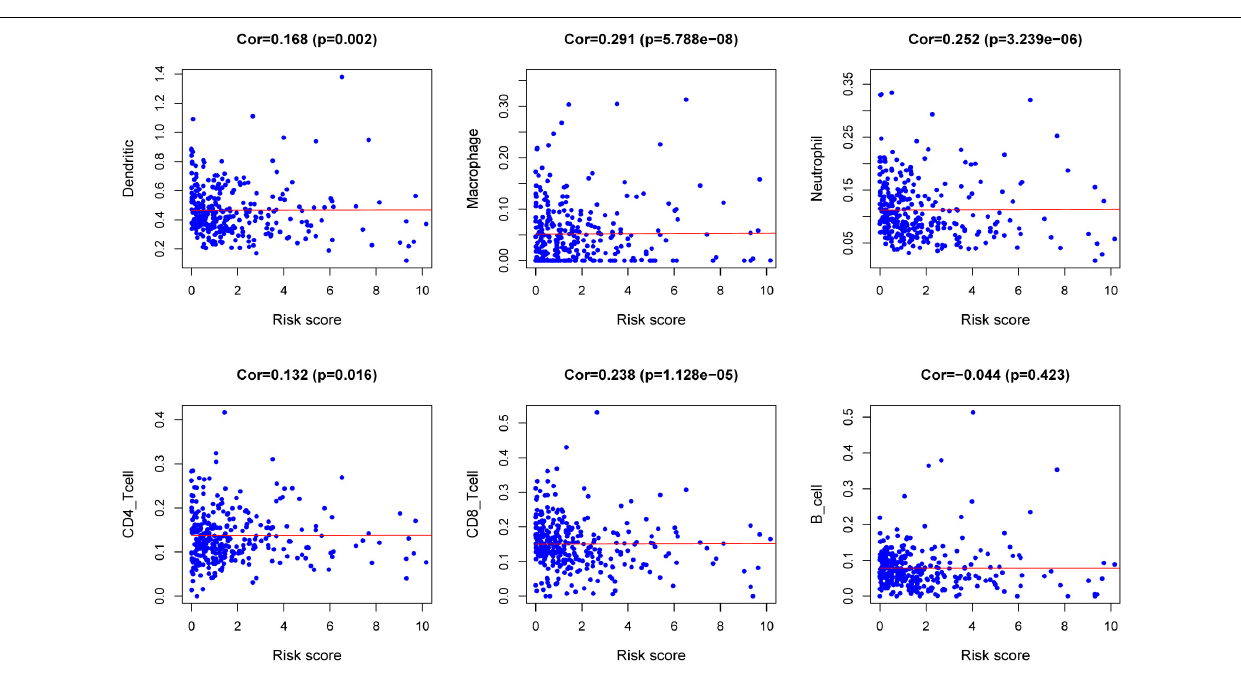
FIGURE 8 | Relationships between the risk score model and infiltration abundances of six types of immune